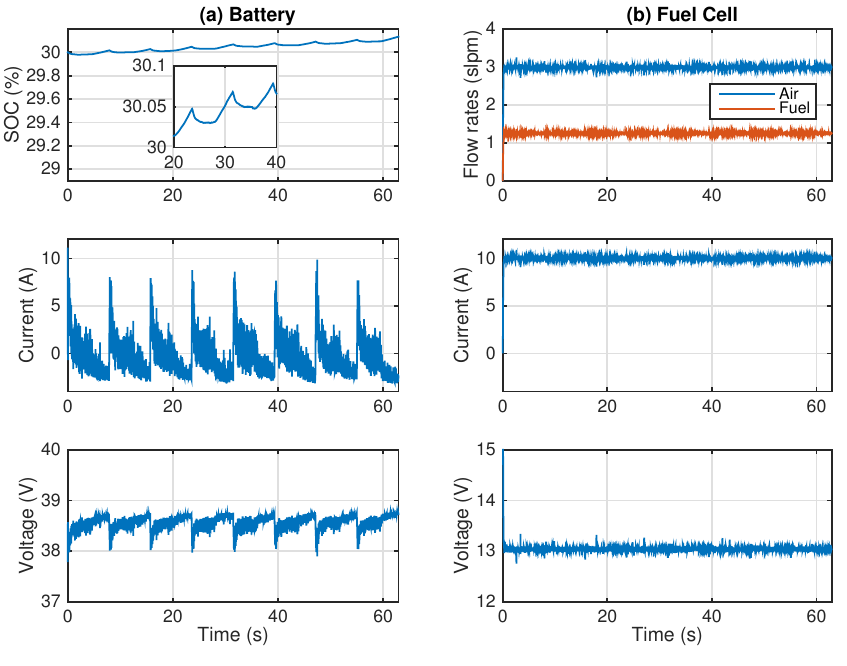
Figure 27. Low-SOC full-active hybrid simulation. ( a ) Battery response and ( b ) FC